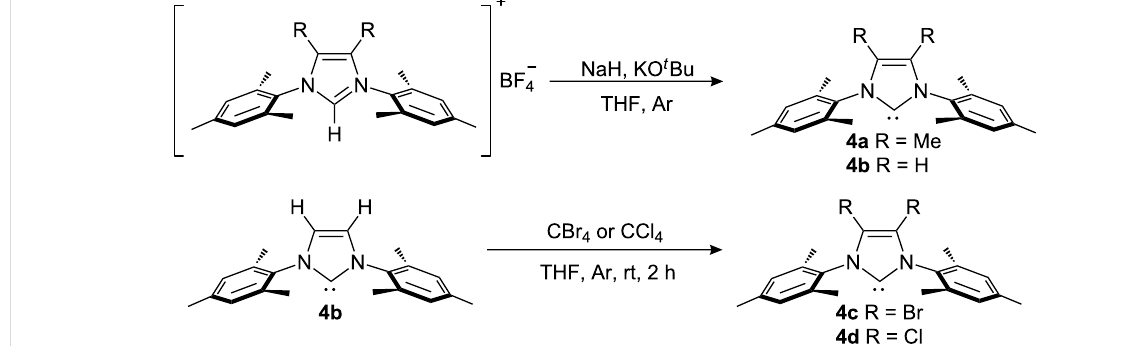
Scheme 1: Synthesis of the free NHCs.